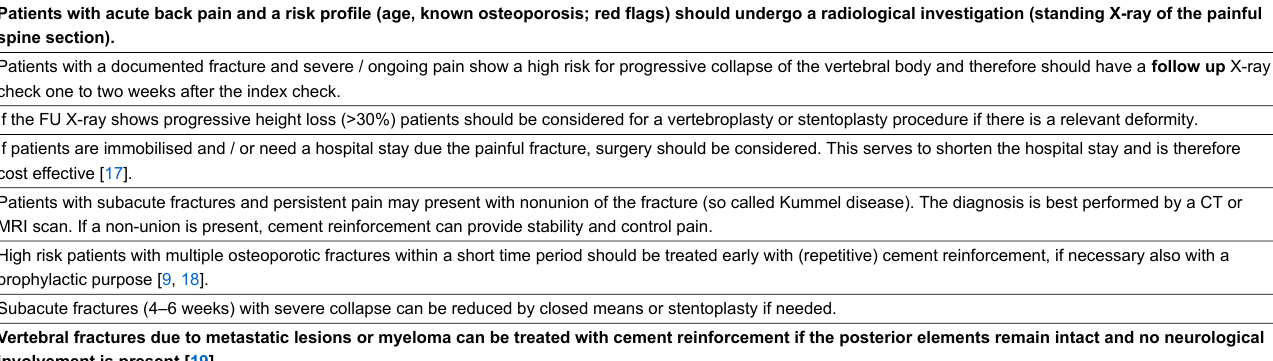
Algorithm for the assessment and treatment of patients with osteoporotic vertebral fractures: Patients presenting with acute, severe back or low back pain and a risk profile (red flags) age >65, history of previous fractures, renal disease, steroid medication, BMI <20 etc.) should undergo an imaging study. The investigation of first choice remains a standing X-ray of the region of interest in two planes. If there is any uncertainty an MRI or CT scan can further differentiate between old and new fractures and provide a more detailed impression regarding the exact type of lesion and allow to differentiate between a simple compression type fracture or a complex lesion. The comparison of a standing film with an investigation taken in supine position is helpful for detecting a mobility in the fractured vertebra. Based on clinical findings and the results of the imaging studies one can decide the further treatment. Patients who need hospital admission due the severity of pain or patients with complex lesions should be referred for an early surgical intervention. The majority of patients will remain outpatient. For them it is important to monitor the clinical course and if there is persisting pain or a high risk situation based on their history a follow up X-ray is mandatory in order to check for further height loss of the fractured vertebra or new fractures. If so, again a surgical intervention should be considered. Patients with a spinal stenosis and neurological symptoms usually need an open surgical procedure with decompression and